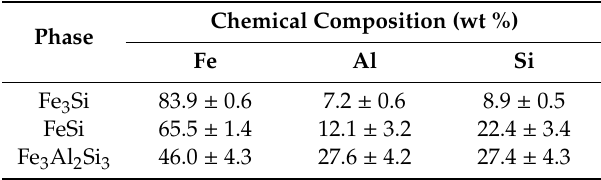
Table 1. Average chemical composition of individual phases in FeAl20Si20 alloy (determined by EDS).